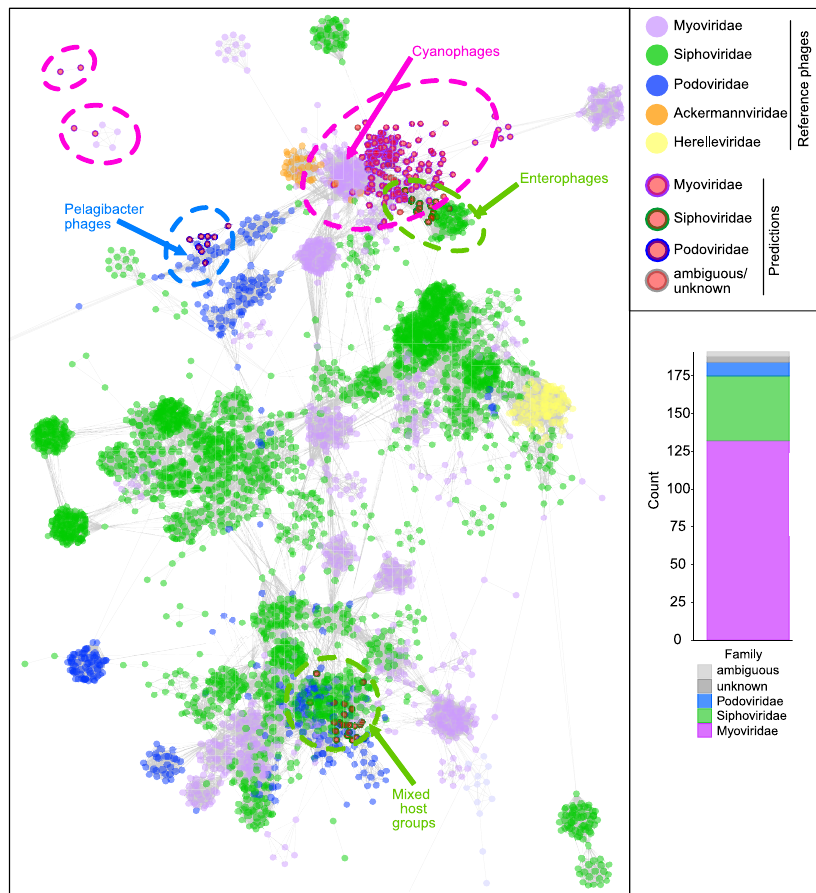
Fig. 4 Taxonomic assignment of mVCs and protein network clustering with reference phages. In the protein network each dot represents a single mVC (circles with outlines) or reference phage (circles without outlines), and dots are connected by lines respective to shared protein content. Genomes (i.e., dots) having more similarities will be visualized by closer proximity and more connections. Cluster annotations depicted by dotted lines were approximated manually. mVC taxonomy was colored according to predictions by a custom reference database and script, shown by bar chart